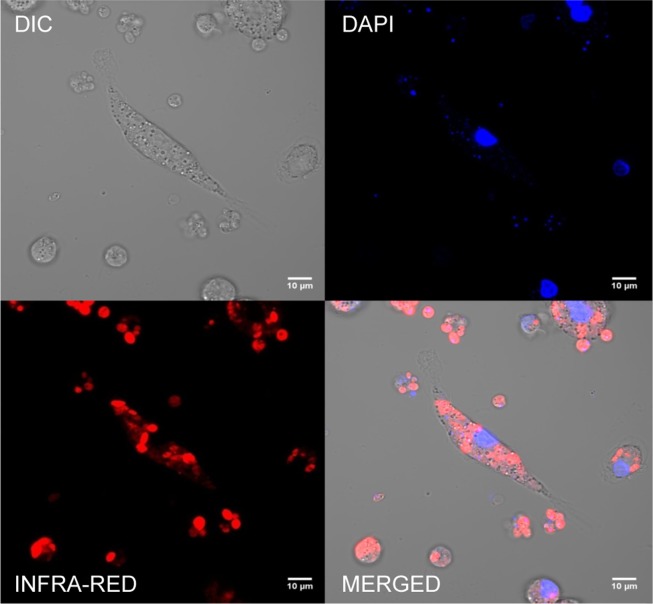
Confocal microscopy analysis of splenic explants infected with HSP70+L. infantum amastigotes.A) Differential Interference Contrast (DIC). B) HSP70+L. infantum emitting infrared fluorescence. C) DAPI staining of nucleic acids. D) Merged images. Microscopy images were acquired with a Zeiss LSM710 confocal microscope.